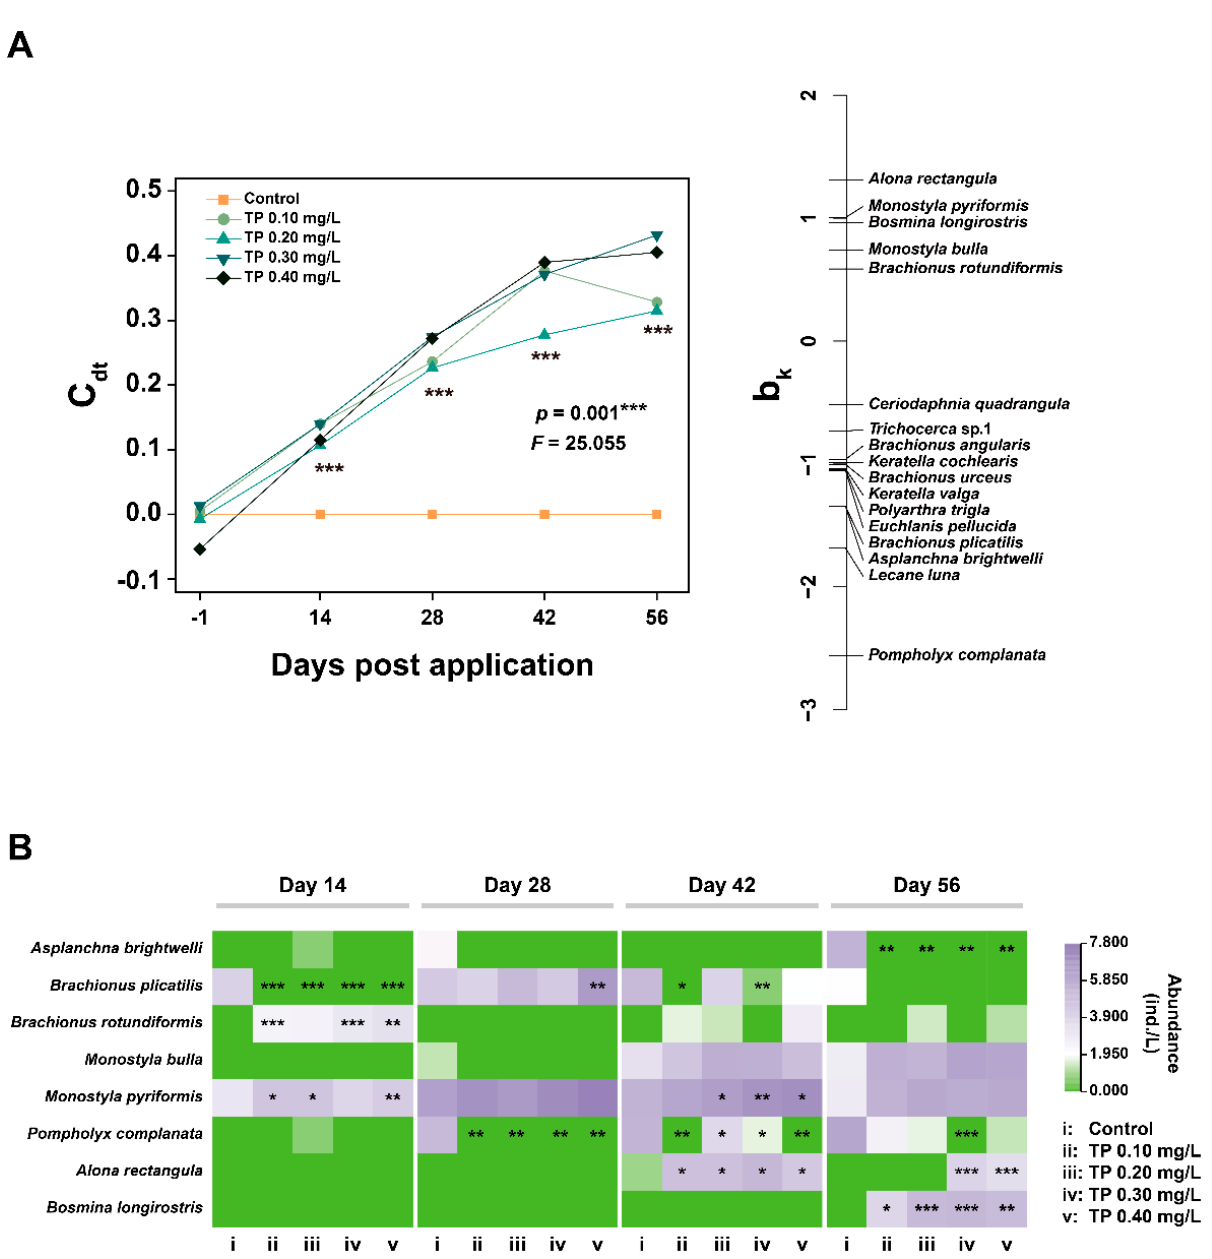
Figure 6. PRC diagram ( A ) and the responses of species abundance ( B ) to TP of zooplankton datasets. The abundance data were ln(ax+1) transformed. Significant differences are indicated in the figure, p ≤ 0.05 is marked as *, p ≤ 0.01 is marked as **, and p ≤ 0.001 is marked as ***.